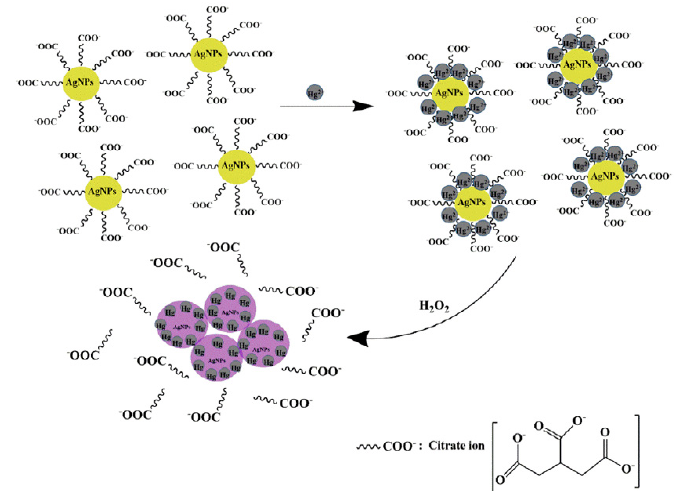
Fig. 12. Proposed mechanism for the Hg 2+ -induced-colorimetric response of AgNPs in presence of H